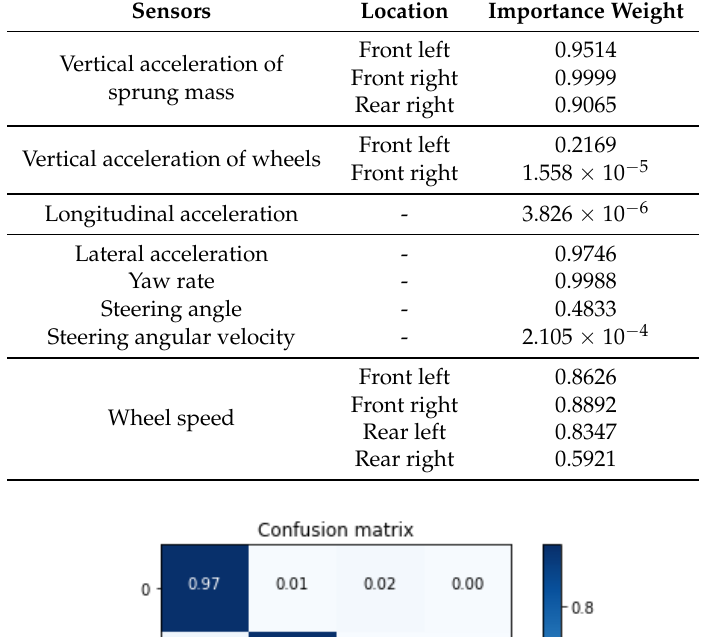
Table 4. Classification accuracy of the single network and the ensemble network.